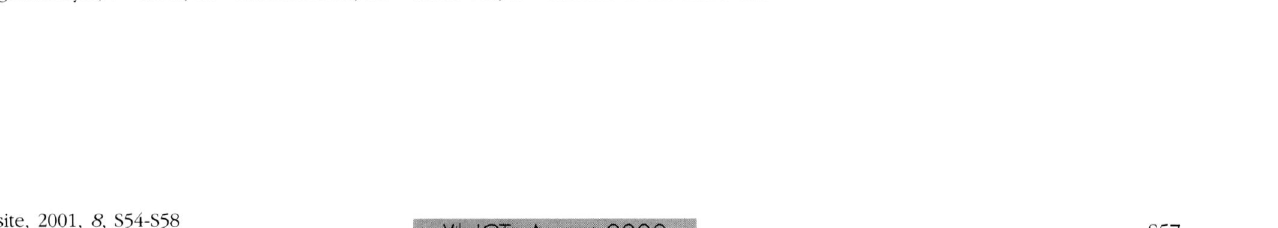
Parasite, 2001, 8,